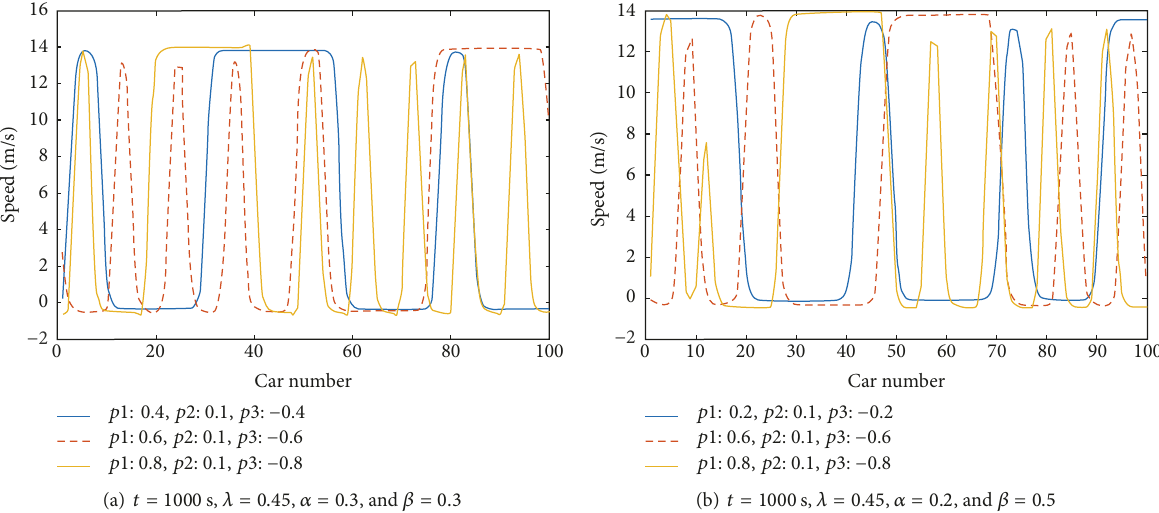
Figure 9: Snapshot of the velocities of all vehicles with different 𝑝 1 , 𝑝 2 , 𝑝 3 .